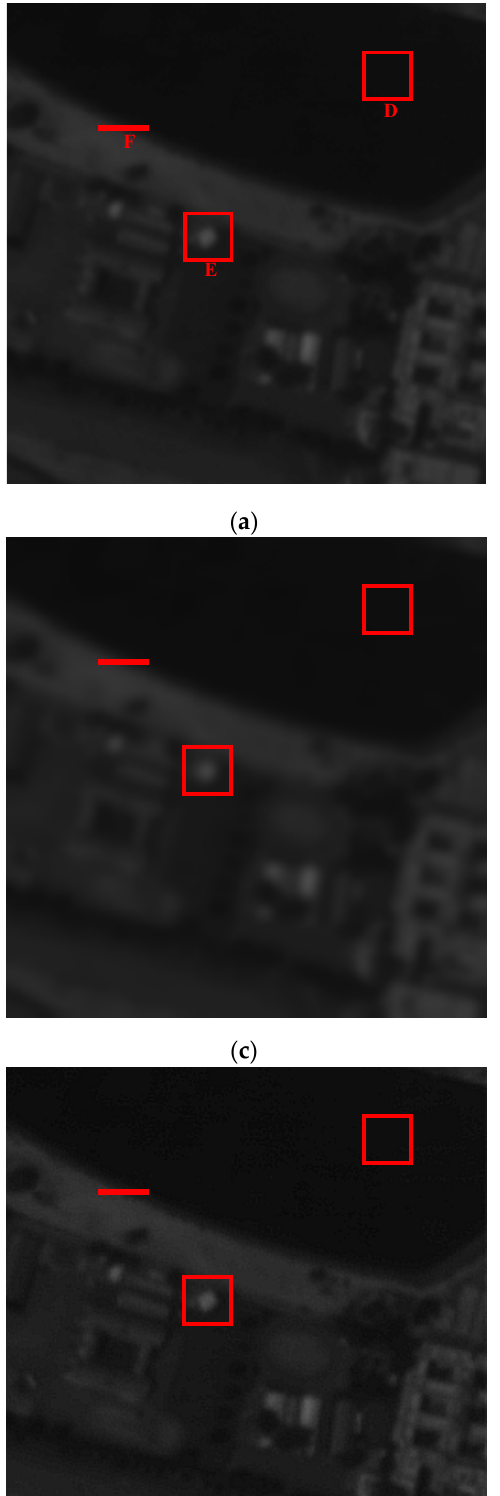
region. The zoomed in images of box E for UMF, BF + UMF, and IASF are shown in Figure 4h. The gray level distributions of edge F are depicted in Figure 4i,j.